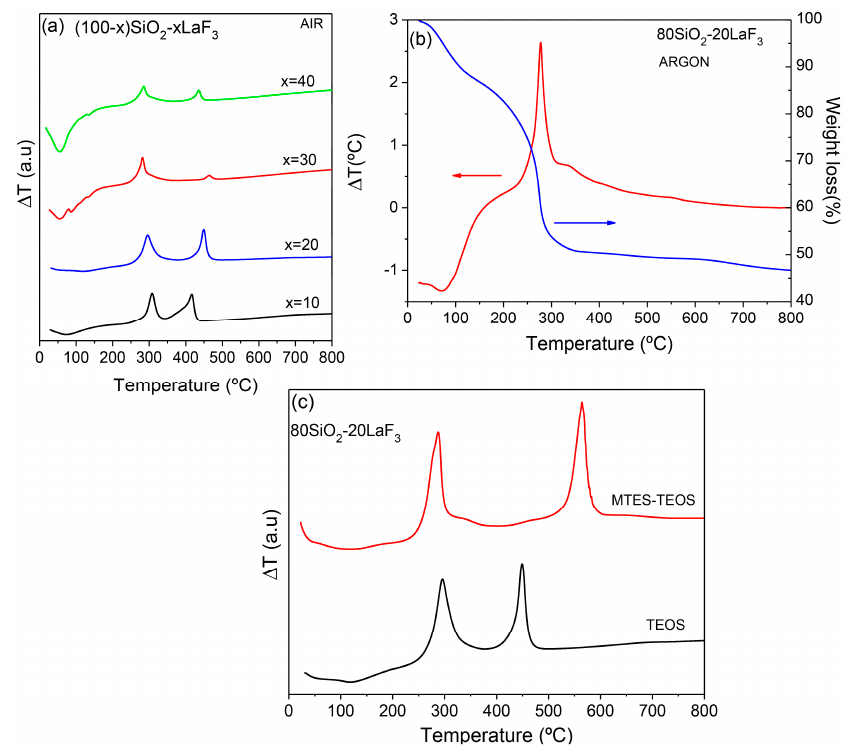
Figure 8. ( a ) DTA in air of (100 − x)SiO 2 -xLaF 3 (x = 10–40 mol %) bulk samples prepared with TEOS; ( b ) DTA and TG in argon atmosphere of 80SiO 2 -20LaF 3 bulk samples prepared with TEOS; ( c ) DTA in air of 80SiO 2 -20LaF 3 bulk samples with TEOS and TEOS/MTES. All measurements were performed using a heating rate of 10 °C/min.